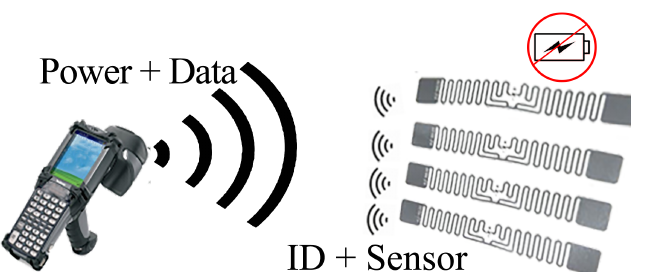
Figure 2. Battery-less wireless sensors draw energy from the reader and respond by backscattering the incident power